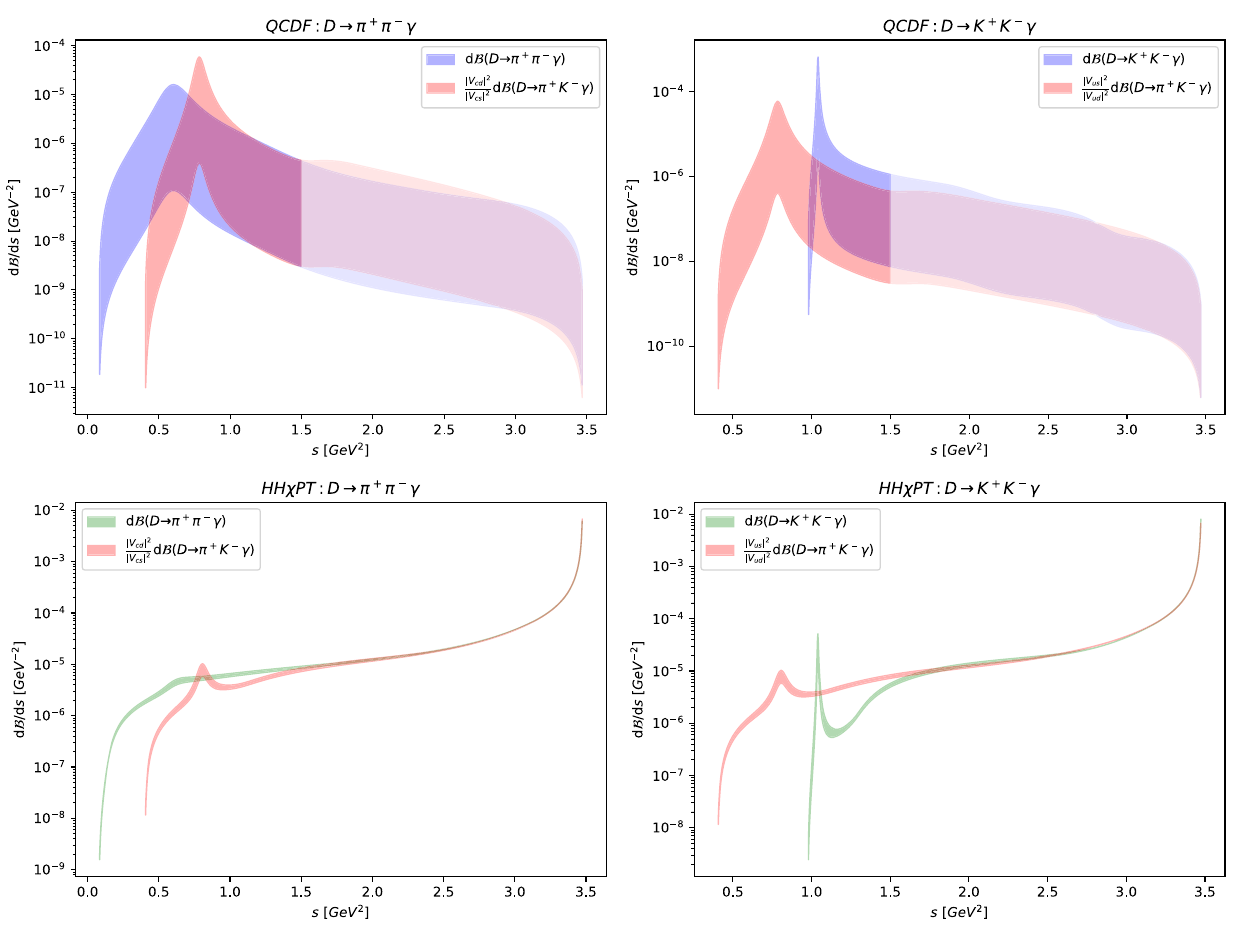
Fig. 6 The SM predictions for the differential branching ratios of the decays D → π + π − γ (left) and D → K + K − γ (right) from a direct QCDF computation (blue bands in upper plots), HH χ PT computations (green bands in lower plots) and from the D → K − π + γ distribution